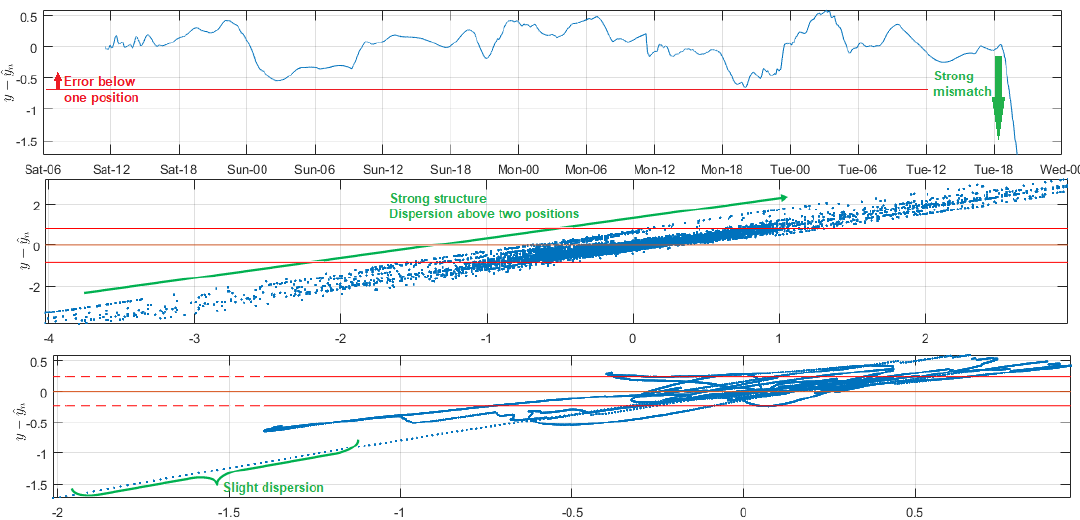
Figure 10. Representative rhythmometric analysis plots. From top to bottom: Non-filtered modeled signal ( Reg = 2000), filtered modeled signal ( Reg = 1700), residual time evolution without and with filter, and Bland–Altman diagram without and with filter.